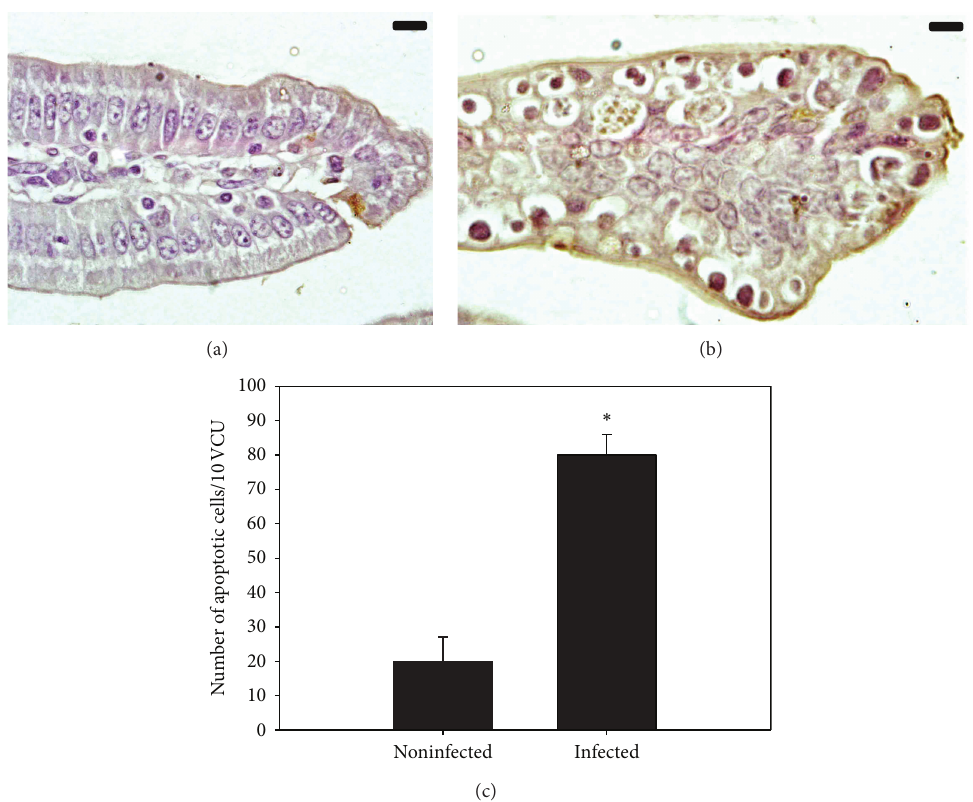
Figure2:Changesinapoptoticcellsinmousejejunuminfectedwith E.papillata .(a)Noninfectedjejunum(b)Infectedjejunumwithincreased number of TUNEL-positive cells in lamina propria. Bar = 25 𝜇 m. (c) Infection-induced changes in apoptotic cells number in jejunal crypts. Values are means ± SD. ∗ Significant at 𝑃 ≤ 0.05 . 𝑛 = 10